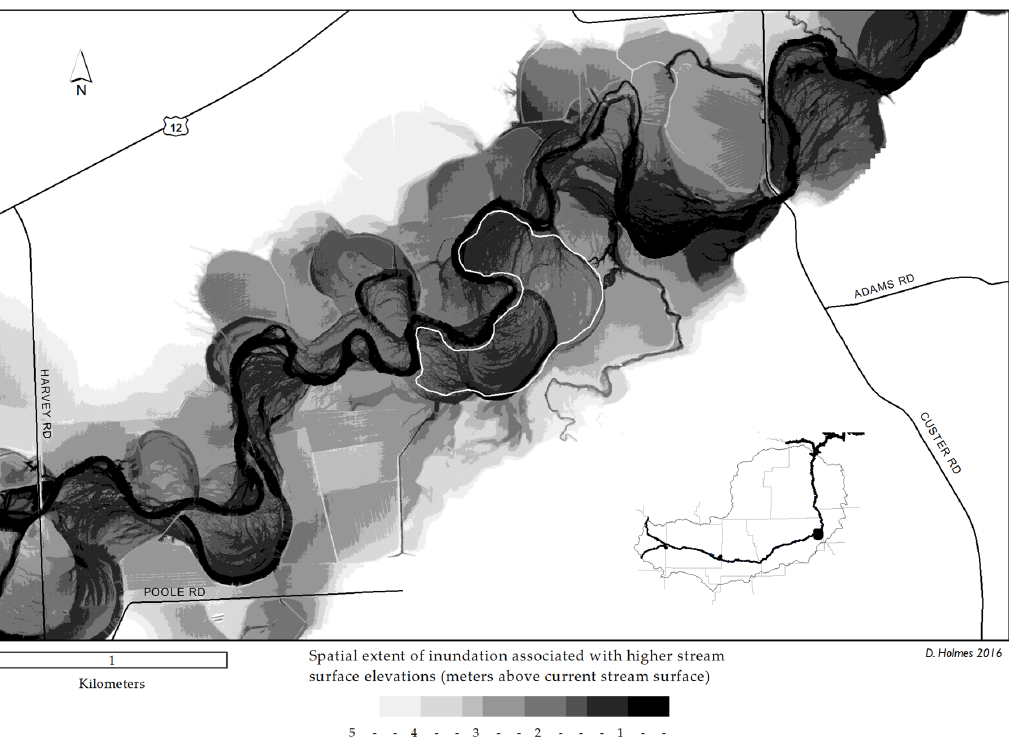
Figure 6. Study site inundation map showing the extent of flooding associated with different MSR surface elevation increases. Storage potential calculation was isolated to the study site. While the surrounding area has the potential to (and during a real event would) store flood water, it was not included in storage potential modeling, though it was included in inundation simulation. The site is entirely inundated when the stream surface increases in elevation by 3 m.